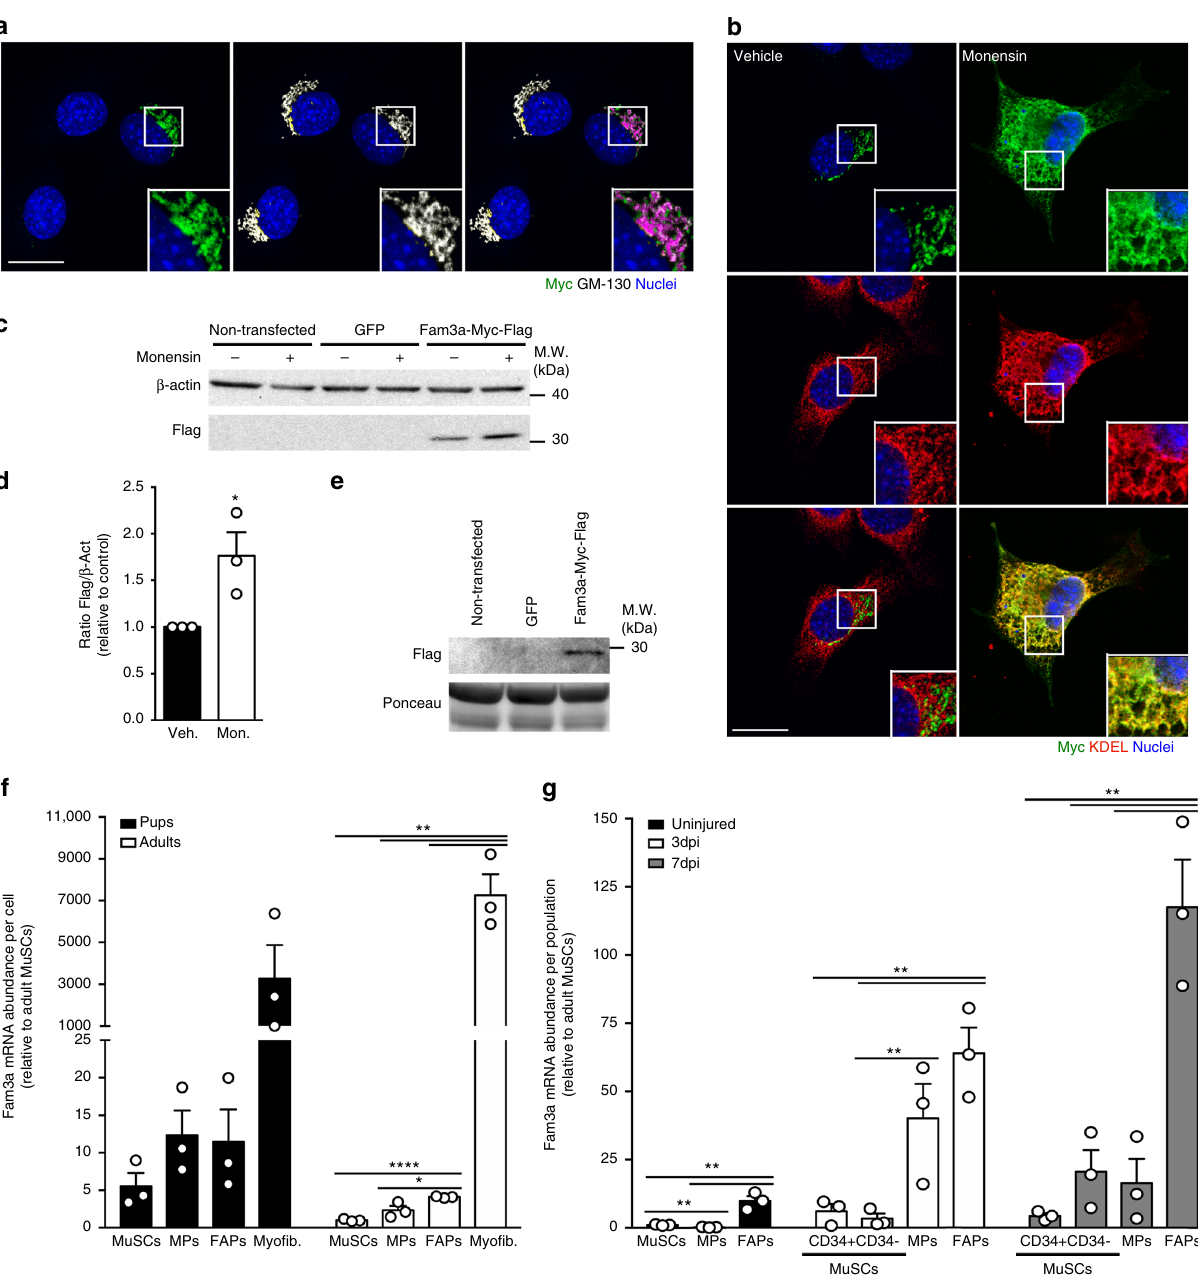
Fig. 5 Fam3a is secreted by myogenic cells. a , b Immuno fl uorescence analysis of C2C12 myogenic cells transfected with a construct to overexpress Fam3a- Myc-Flag. GM-130 is a cis-Golgi marker. KDEL is an endoplasmic reticulum marker. Purple or yellow colors mean colocalization. When indicated, cells were treated with Monensin (200 μ M) for 4 h. Scale bars 20 μ m. c , d Western blot analysis of non-transfected C2C12 myoblasts and C2C12 cells transfected with constructs to overexpress green fl uorescent protein (GFP) or Fam3a-Myc-Flag. When indicated, cells were treated with Monensin (200 μ M) for 4 h ( n = 3 independent experiments). e Western blot analysis of the media from C2C12 cells transfected with a construct to overexpress Fam3a-Myc-Flag. f Fam3a mRNA abundance per cell in freshly isolated muscle stem cells (MuSCs), macrophages (MPs), fi broadipogenic progenitors (FAPs), and myo fi bers from C57BL6/J P15 pups ( n = 3 biologically independent samples; 3 pups were pulled per sample) and 3-month-old adult male mice ( n = 3 animals). g Fam3a mRNA abundance per population in freshly isolated MuSCs, MPs, and FAPs from uninjured, 3 dpi, and 7 dpi 3-month-old male mice ( n = 3 animals). Data are represented as mean ± SEM (Student ’ s t test; * p < 0.05, ** p < 0.01, **** p <